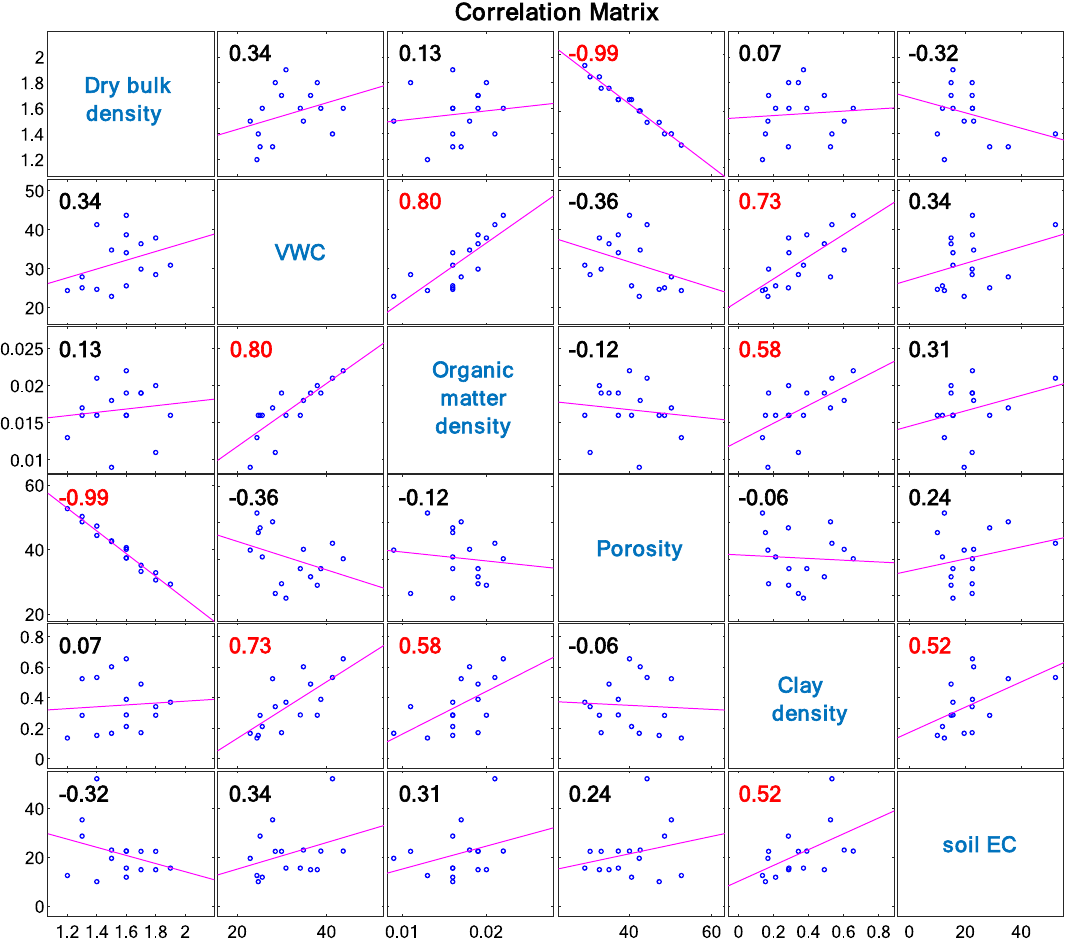
Figure 8. Correlation matrix between soil EC a and soil properties: dry bulk density (g/cm 3 ), volumetric water content (VWC) (%), organic matter density (g/cm 3 ), porosity (%), and clay density (g/cm 3 ). Values that are significant are shown in red (alpha = 0.05).